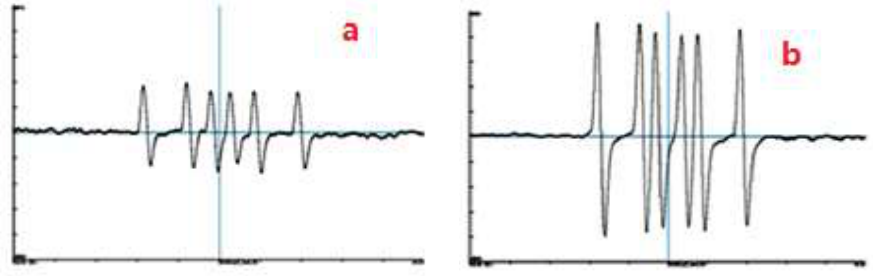
Figure 6. ESR spectra of the ( a ) Ni(IV)-Lu and ( b ) Ni (IV)-Lu-SAL system. Reaction conditions: [Ni] =2.0 × 10 −4 M; [Lu] = 3.0 × 10 −3 M; [OH − ] = 6.0 × 10 −3 M; [SAL] = 6.0 × 10 −4 M.